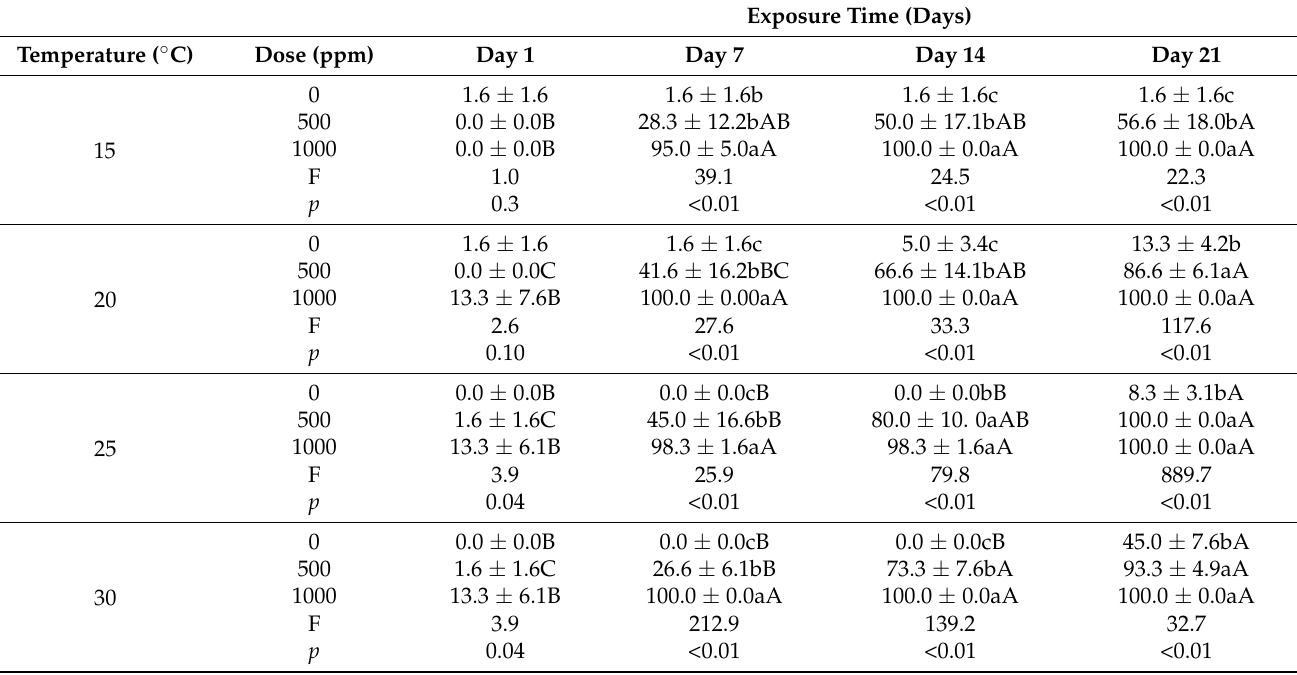
Table 4. Mean mortality (% ± SE) of O. surinamensis adults exposed for 1, 7, 14, and 21 days to wheat treated with three different doses of diatomaceous earth (0, 500, and 1000 ppm) and four different temperatures (15, 20, 25, and 30 ◦ C), at 55%